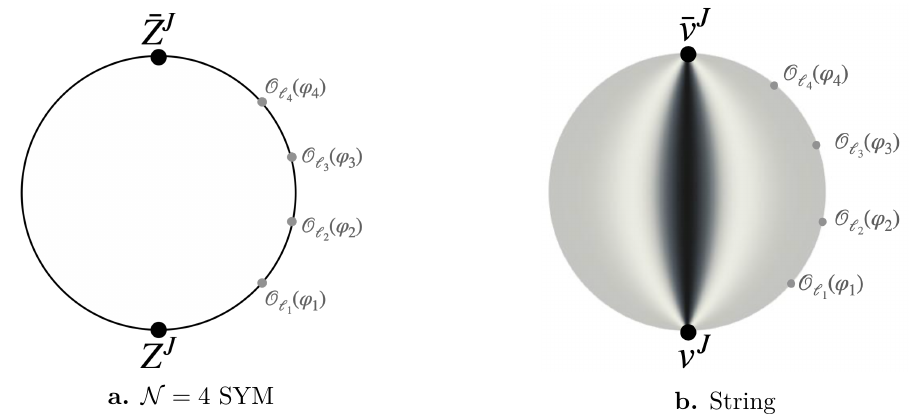
Figure 1 . Large charge correlation functions on the gauge theory side and on the string theory side. a. Correlation functions of insertions on the half-BPS circular Wilson loop. In this paper, we √ take two of them ( Z J and ¯ Z J ) to have large charges ( J ∼ ( ϕ ) ’s) to be λ (cid:29) 1) and the others ( O ‘ j j light. b. At strong coupling, the same correlation functions are described by a non-trivial classical string solution which ends at the Wilson loop on the boundary. In the absence of the insertions, the string worldsheet lies on the Euclidean AdS subspace inside AdS 5 . The large charge insertions 2 5 × S deform this solution and the string worldsheet has a non-trivial profile around the insertion points. As an illustration of the string solution, the figure above shows a density plot of the worldsheet curvature. The leading large J answer can be computed by evaluating the light vertex operators on this deformed